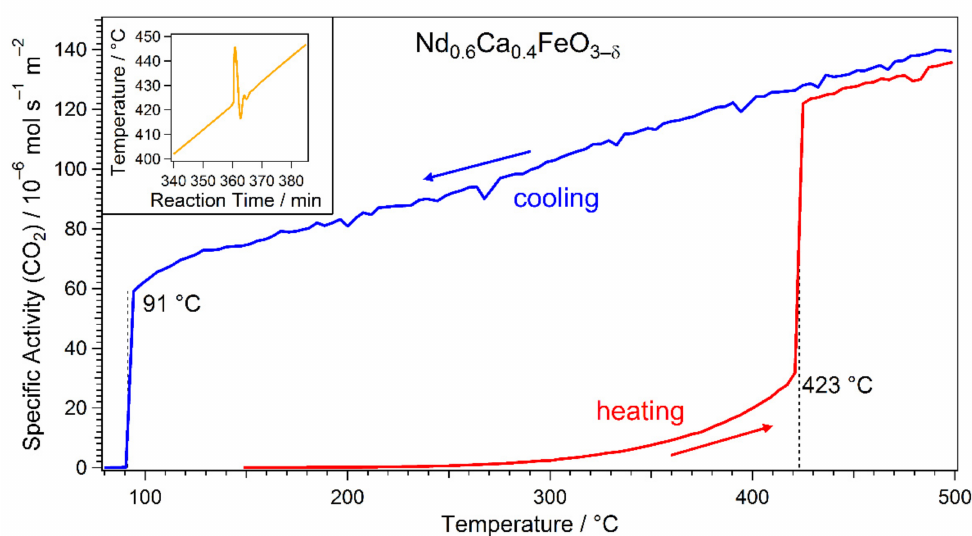
Figure 4. Hysteresis of Nd 0.6 Ca 0.4 FeO 3- δ (Nd06): Ignition (onset of significant catalytic activity) upon heating the sample (red curve) happens at 423 ◦ C, while catalytic activity persisted far below that temperature during the cooling of the sample (blue curve). For Nd06, extinction (a significant sudden drop of specific activity) was found to happen at 91 ◦ C. The inset shows an additional thermal effect that could be observed during heating: Due to the exothermic nature of CO oxidation, the temperature spikes around ignition as additional heat is released during the reaction—the peak below the target temperature immediately after this spike arose from the PID controller of the heating overcorrecting. The inverse effect was found around extinction (not shown).